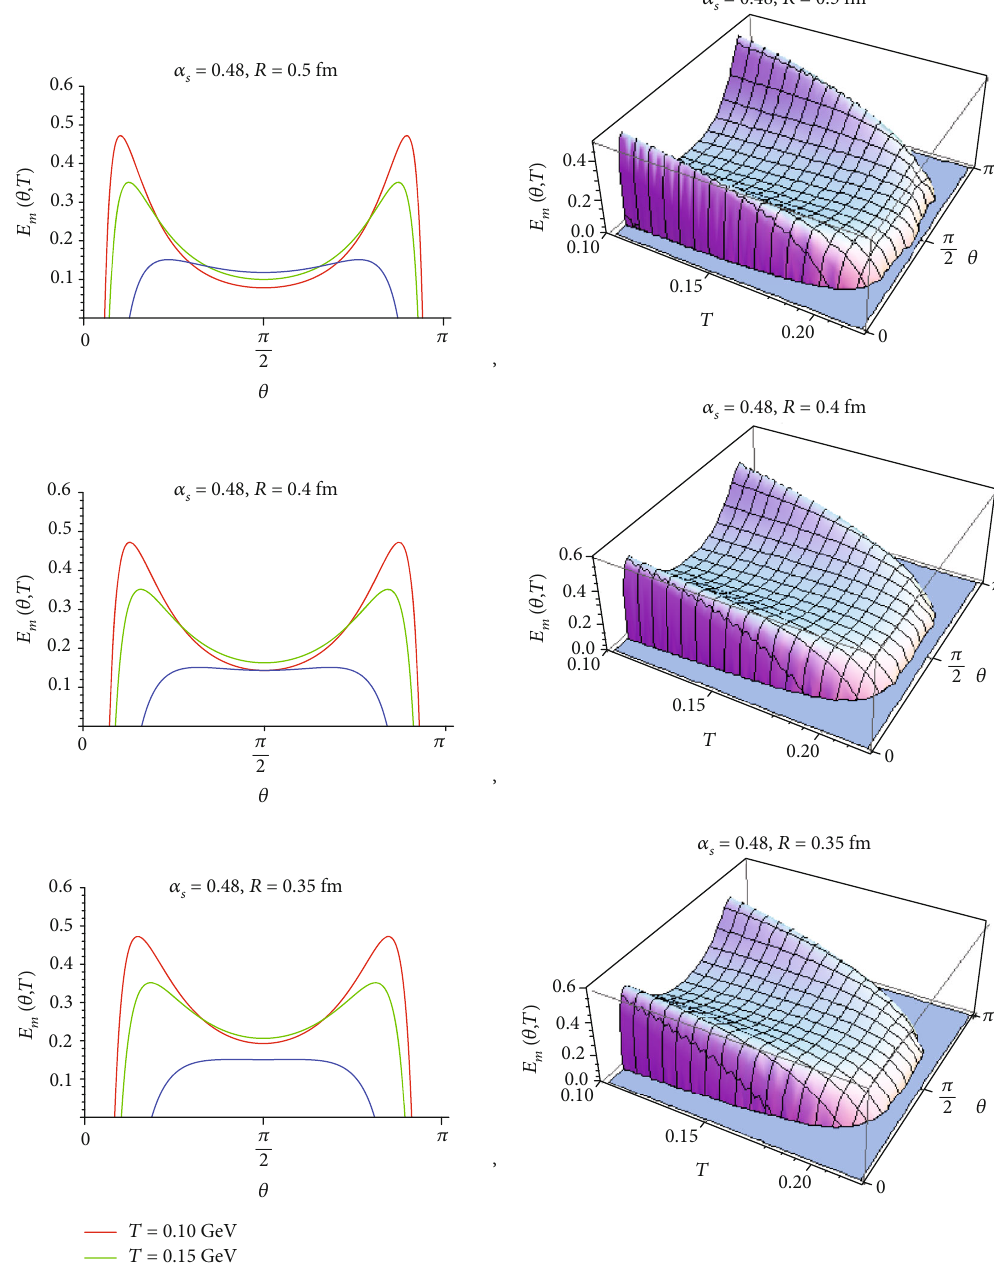
= 0 : ð θ , T Þ at α m s